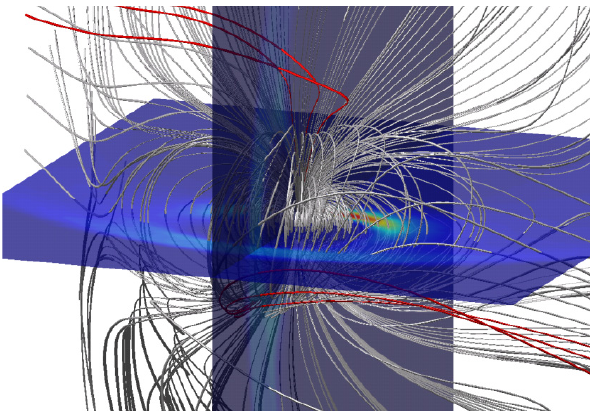
Fig. 3. 3-D representation of the global magnetic field lines of a BATS-R-US run for the 14 February 2001; 10:46 UT. The solid lines indicate the field line configuration, the red lines indicate the open magnetic field topology at the Cluster spacecraft position; the structure coincidents with the postulated structure by Russell and